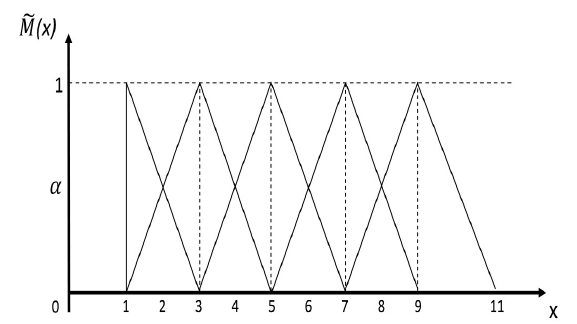
Figure 3. Membership functions of triangular fuzzy numbers corresponding to the linguistic scale